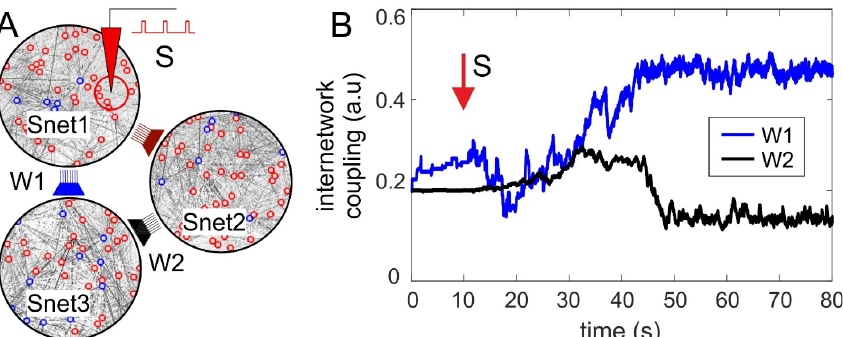
Figure 4. The shortest pathway rule for modular SNNs solves the problem of depressing synapses not involved in relevant associations of stimuli. ( A ) The network architecture. Subnet 3 receives input from subnet 1 directly and through subnet 2. The rule states that the shortest path (through W1) is potentiated while the longer (through W2) is inhibited. ( B ) Dynamics of the internetwork connections. The red arrow indicates the moment when the stimulation is turned on.